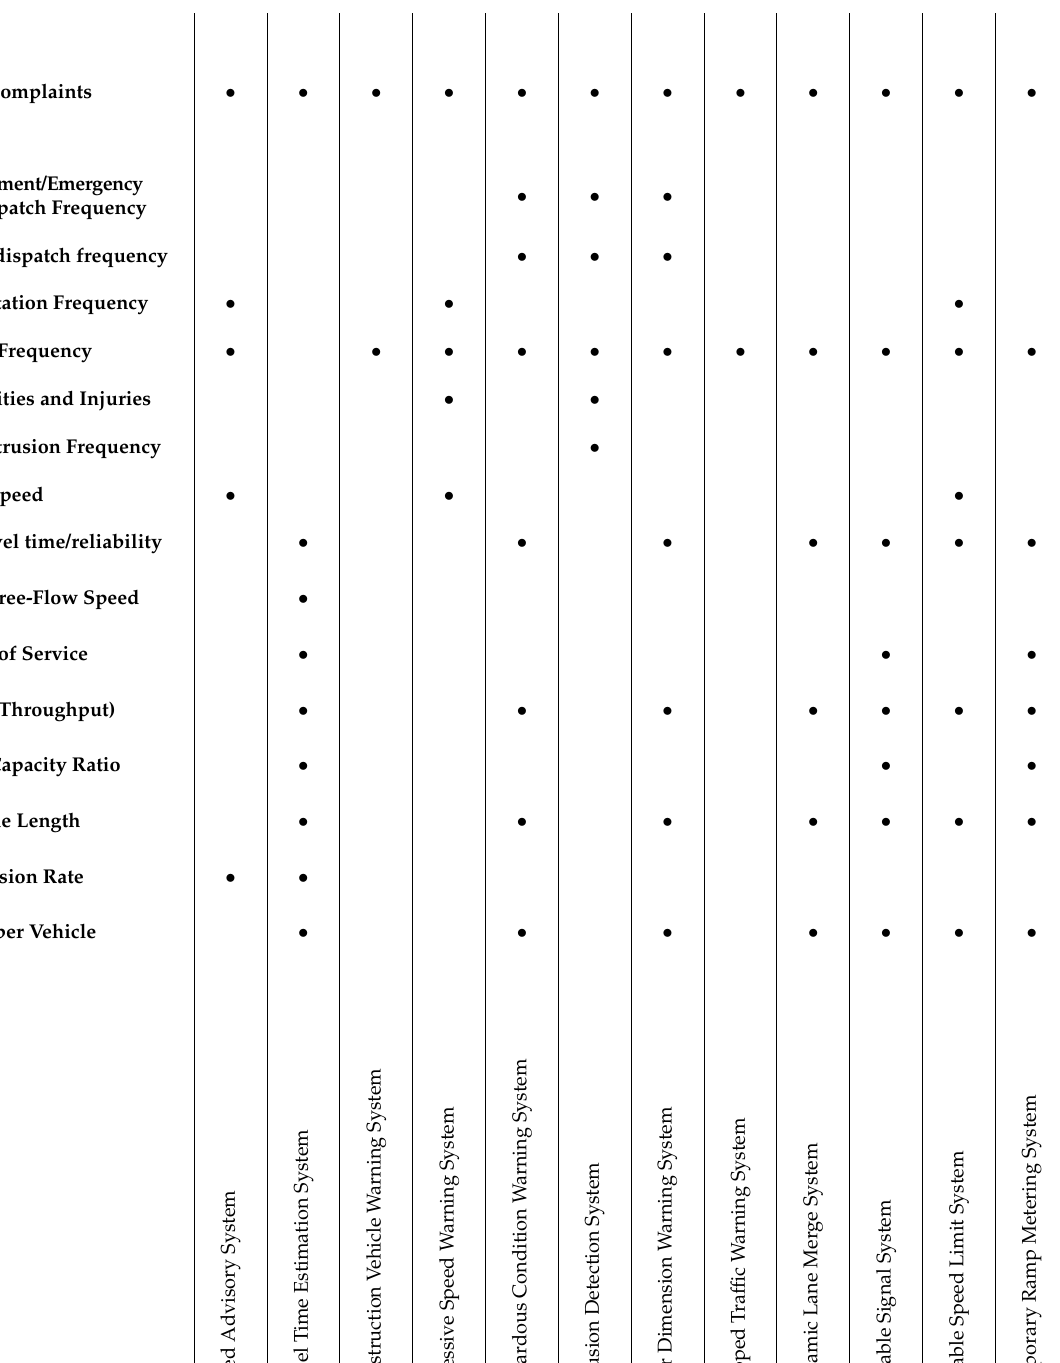
Table 5. Performance measures for evaluating work zone